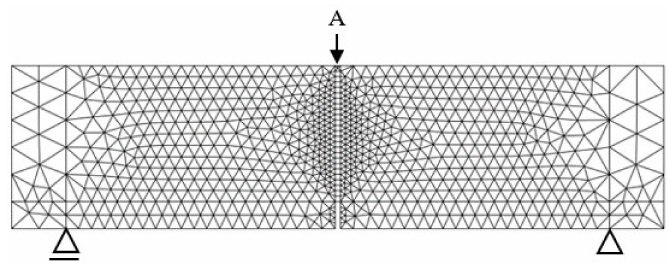
Figure 16. Finite-element mesh and boundary conditions for the beam used in numerical